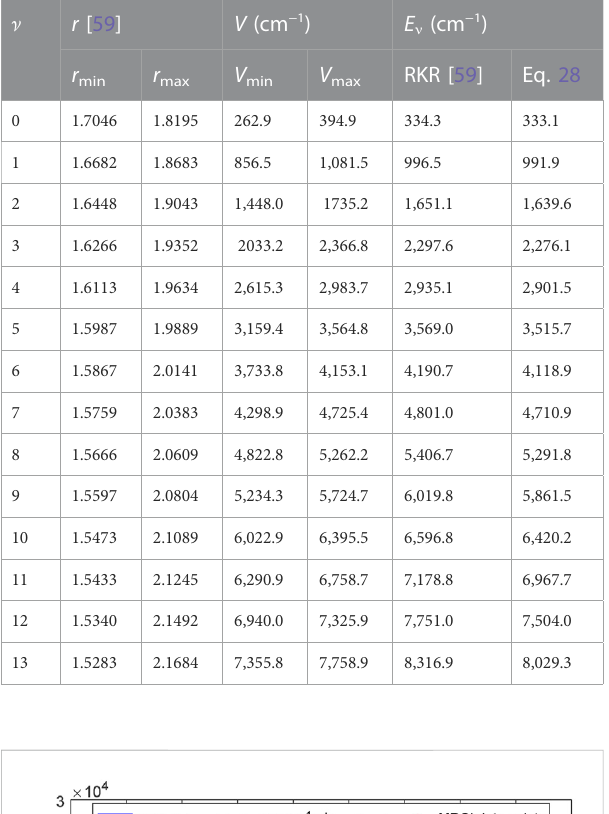
TABLE 3 Potential energies (cm) and bound state pure vibrational state energies (cm − 1 ) as a function of internuclear separation (Å) for the BrF (X 1 Σ + ) molecule.